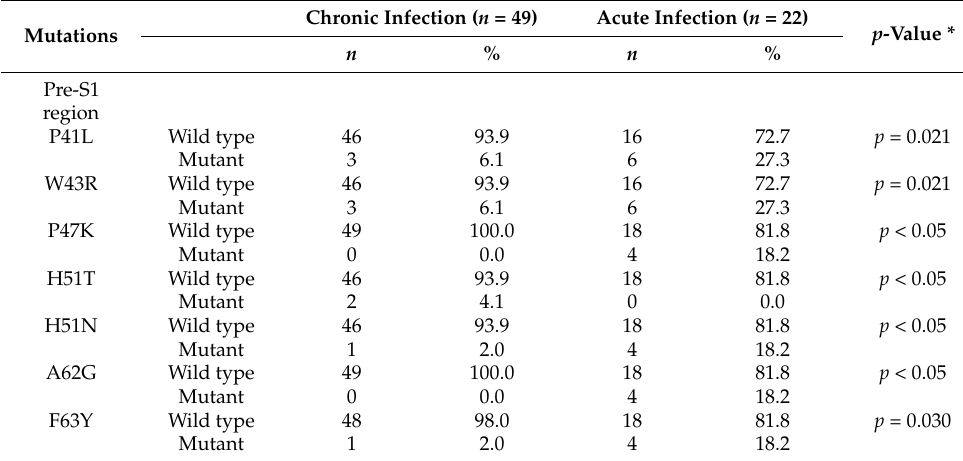
Table 3. Analysis of amino acid substitution in the pre-S1